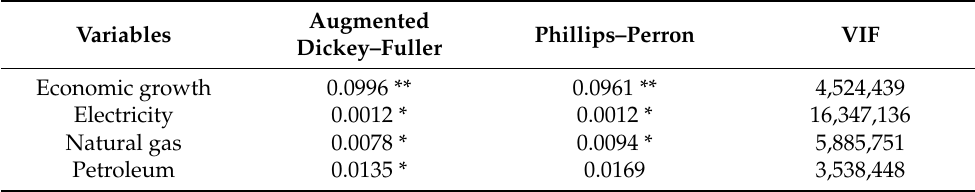
Table 1. Stationarity investigation (normalized variables). Variables